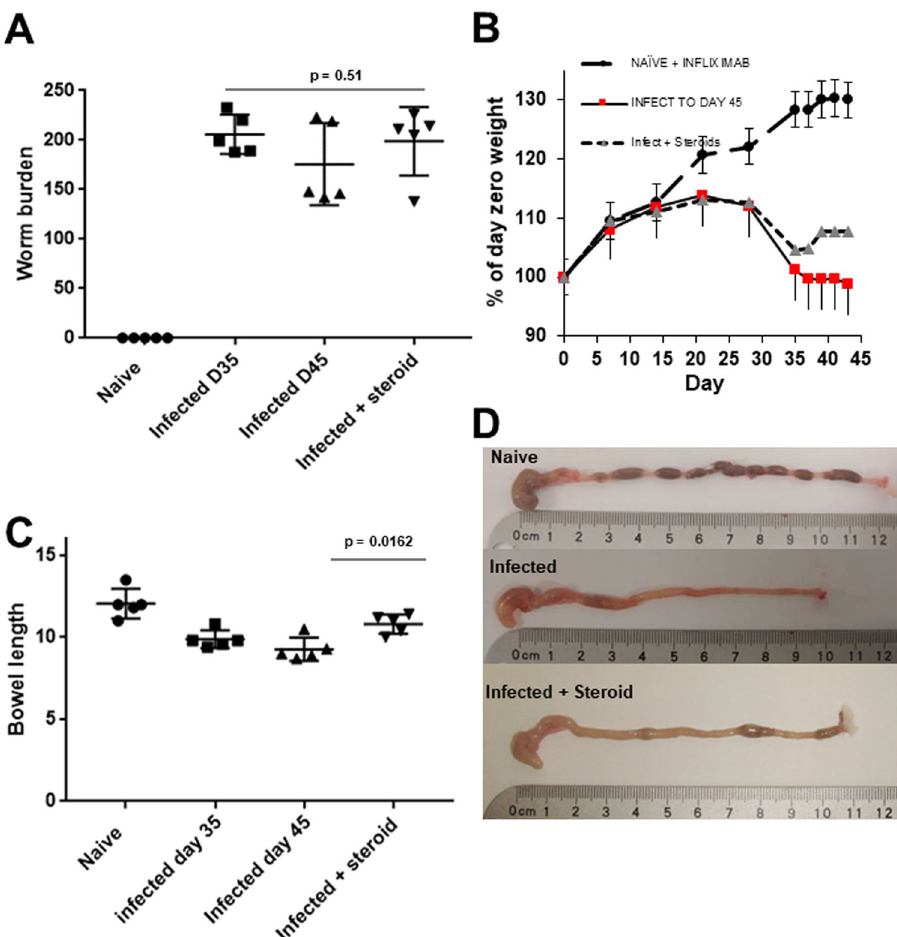
Figure 1. Steroid intervention improved colonic phenotype and body weight of AKR/J mice infected with T . muris . AKR/J were infected with 300 T . muris ova, and studied to 45 days post-infection. Steroids were administered from day 35 p.i. on alternate days. ( A ) The worm burden was not significantly different across infected groups (ANOVA p = 0.51). ( B ) Both infected groups displayed significant weight loss compared to naïve AKR prior to the initiation of treatment on day 35 p.i. (ANOVA, p < 0.0001). Steroid treatment initiated significant weight loss recovery. ( C ) Colonic shortening observed post-infection was ameliorated by steroid treatment. ( D ) Macroscopic colonic appearances across experimental cohorts demonstrated biological differences (shortened, more oedematous, lack of ingesta) in untreated and T . muris infected AKR. The data are expressed as the mean ± SD. n = 5 per group. Data representative of two independent